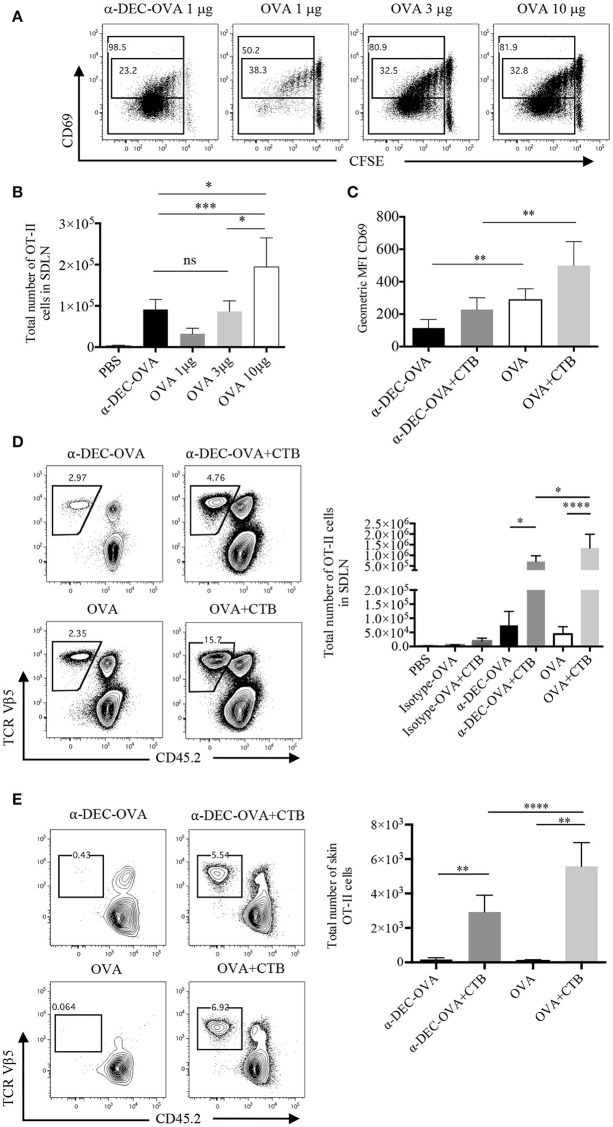
CTB co-administration with a DC-targeted or soluble antigen promotes expansion and differential activation of CD4+ T cells. C57BL6 mice were adoptively transferred with OT-II CD45.1+ cells, 24 h later they were immunized i.d. in both ears, as indicated, and 3 or 7 days later, they were sacrificed for SDLN and skin harvesting. (A) Representative dot plot of CFSE dilution and CD69 expression by SDLN OT-II cells 3 days after inoculation of anti-DEC205-OVA or soluble OVA and (B) total numbers of OT-II cells. (C) Geometric median fluorescence intensity (MFI) of CD69 by OT-II cells 3 days after anti-DEC205-OVA or soluble OVA ± CTB's i.d. administration. Mean ± SD, N = 4–6, data pooled from four independent experiments. One-way ANOVA with Turkey's multiple comparisons test (ns, P > 0.05, *P < 0.05, **P < 0.005, ***P < 0.0005). (D) Representative dot plots and total number of SDLN OT-II cells 7 days after anti-DEC205-OVA or soluble OVA ± CTB's i.d. administration. Mean ± SD, N = 5–8 data pooled from four independent experiments. One-way ANOVA with Tukey's multiple comparisons test (*P < 0.05, ****P < 0.0001). Transferred cells recovered from the SDLN were identified as viable CD4+CD45.2−TCRVβ 5.1, 5.2+ T cells (Supplementary Figure 3A). (E) Representative dot plot and total numbers of migrating OT-II cells identified as viable CD45+CD4+CD45.2−TCRVβ 5.1, 5.2+ (Supplementary Figure 3C). Mean ± SD, N = 4–6, data pooled from four independent experiments. One-way ANOVA with Tukey's multiple comparisons test (**P < 0.005, ****P < 0.0001).